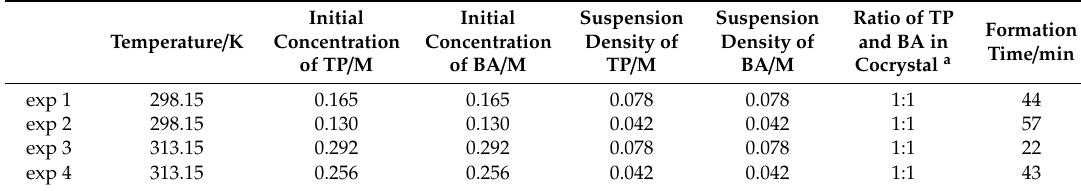
Table 3. Temperature, initial concentration, suspension density of raw materials and formation time in TP-BA cocrystal formation process in slurry crystallization.